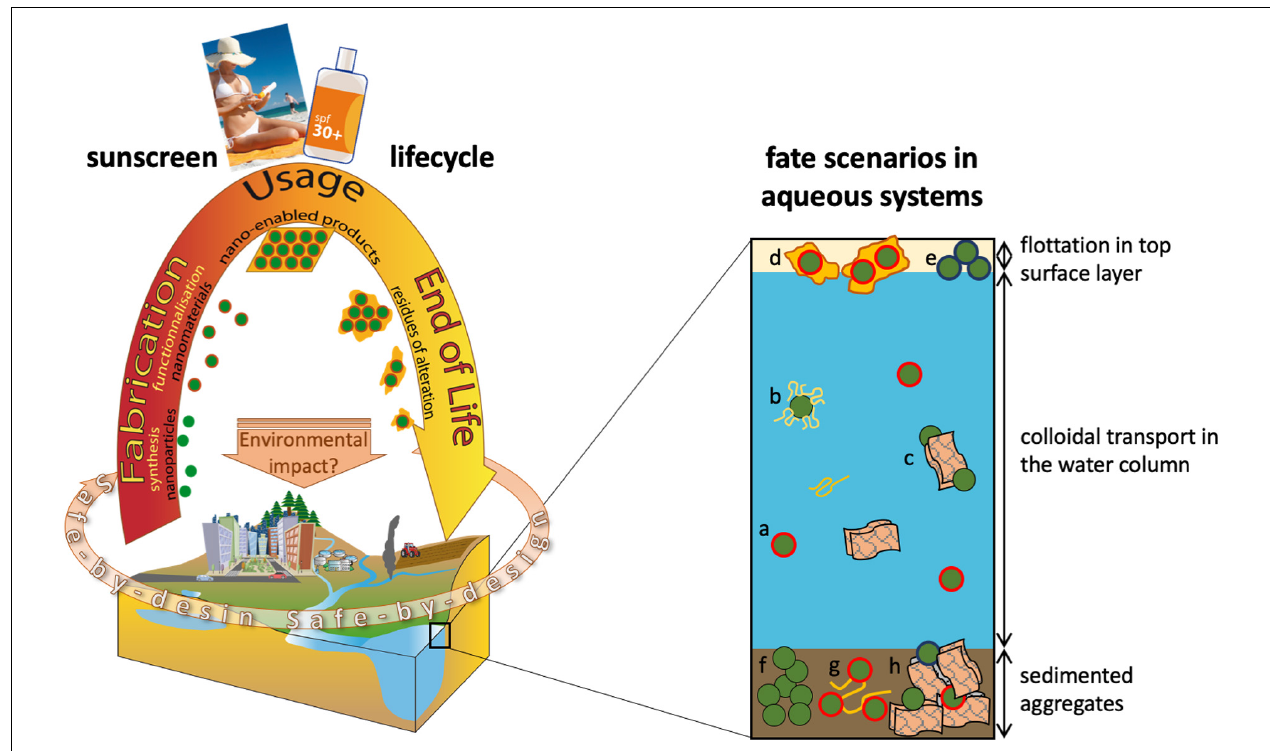
FIGURE 2 | Integrating the entire lifecycle of the sunscreen product from fabrication to end of life enables to anticipate the environmental release and impact of the involved ENMs, and tune the product in a safe-by-design approach to minimize the risk posed. Possible aqueous fate scenarios include (i) stabilization in suspension in the presence of a hydrophilic coating (e.g., SiO 2 , polyacrylate) (a), of natural organic matter adsorbing on the ENM (b), or of natural particulate matter vectorising the ENM (c); (ii) flotation in the water top surface layer if the ENM is embedded in hydrophobic sunscreen ingredients (d), or coated with a hydrophobic layer (e.g., dimethicone, stearic acid) (e); (iii) sedimentation following aggregation due to homoaggregation (f), bridging flocculation (g), or heteroaggregation